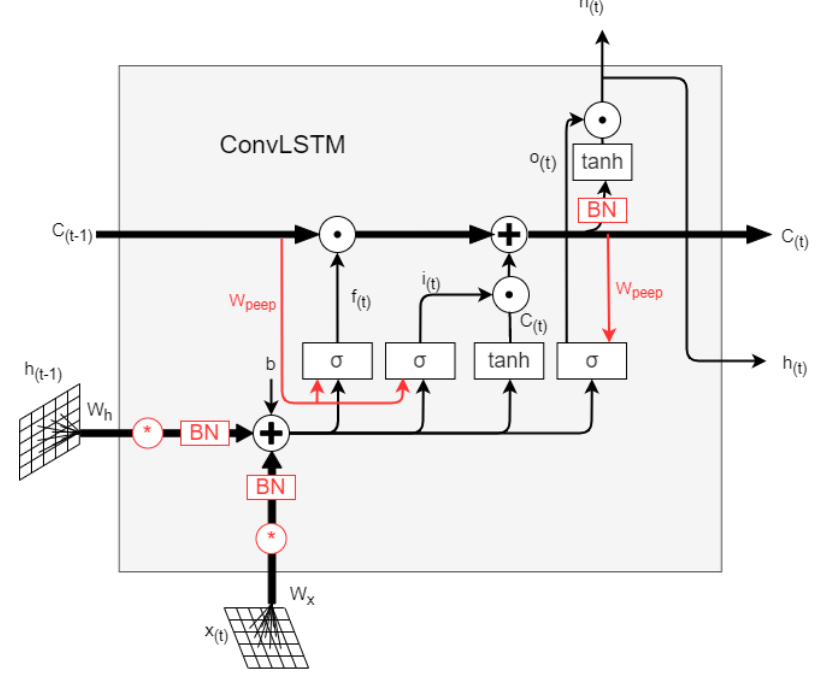
Figure 1. ConvLSTM neural network.